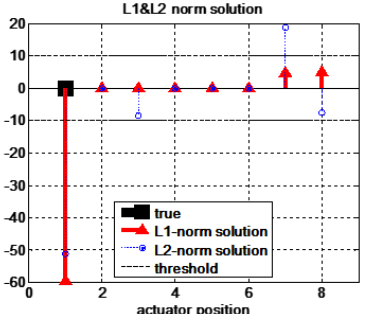
Figure 7. The experimental results of fault isolation with minimal (cid:96) 1 -norm and (cid:96) 2 -norm solution in a steady-state cornering maneuver. The actuator positions are 1(FL), 2(FR), 3(RL), and 4(RR) for the steering angles and 5(FL), 6(FR), 7(RL), and 8(RR) for the driving torques. Structural residual analysis is also conducted for the comparison with our